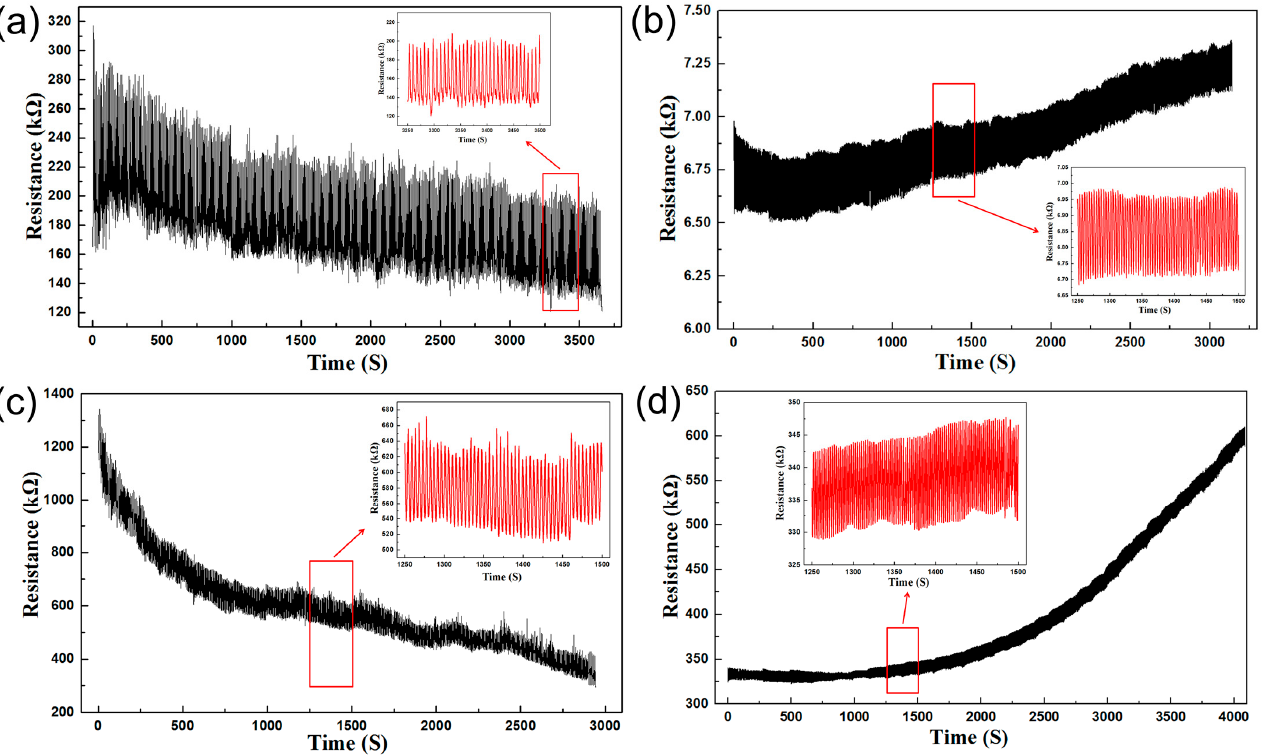
Figure 5. Repeatability tests of the stretchable tactile sensors based on 6CB2CNT-RTV under stretch (500 times) ( a ) and compression (1500 times) ( b ) cyclic loading-unloading. Repeatability testing of the stretchable tactile sensors based on 5.33CB2.67GP-RTV was conducted 500 times stretch ( c ) and 1500 times for compression ( d ) cyclic loading-unloading.